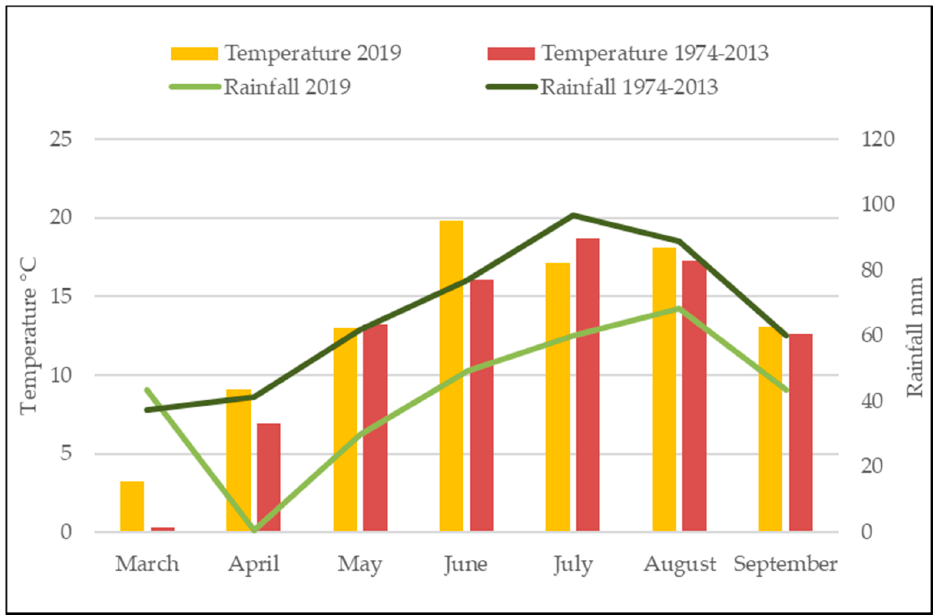
Figure 1. Average temperature and rainfall sum during nettle growing period (Kaunas meteorological station).